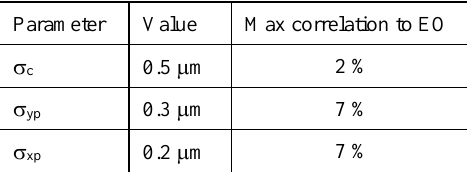
Table 3. Estimated precision of the camera parameters after self- calibration and their correlation to EO